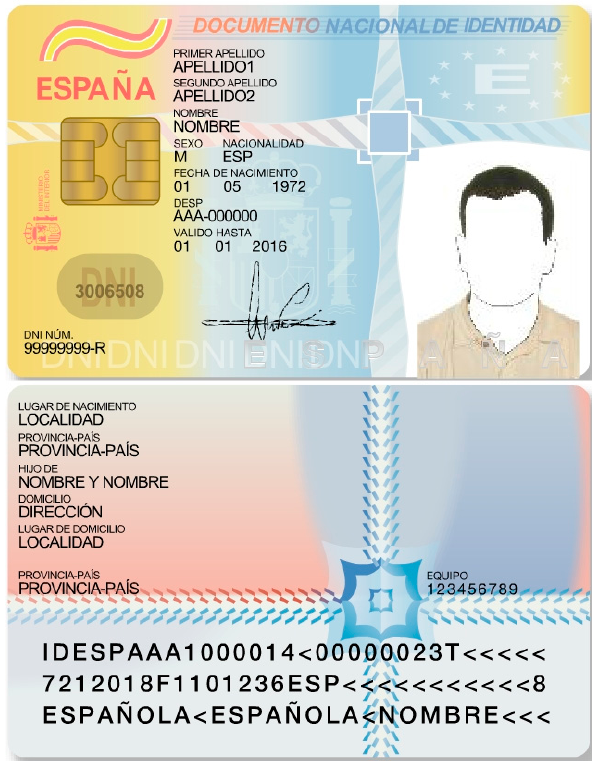
Figure 1. Spanish DNI (National Identity Document) mockup, used under Creative Commons licensing from user Donperfectodewiki on Wikimedia Commons, https://commons.wikimedia.org/wiki/File:Dnie.jpg.